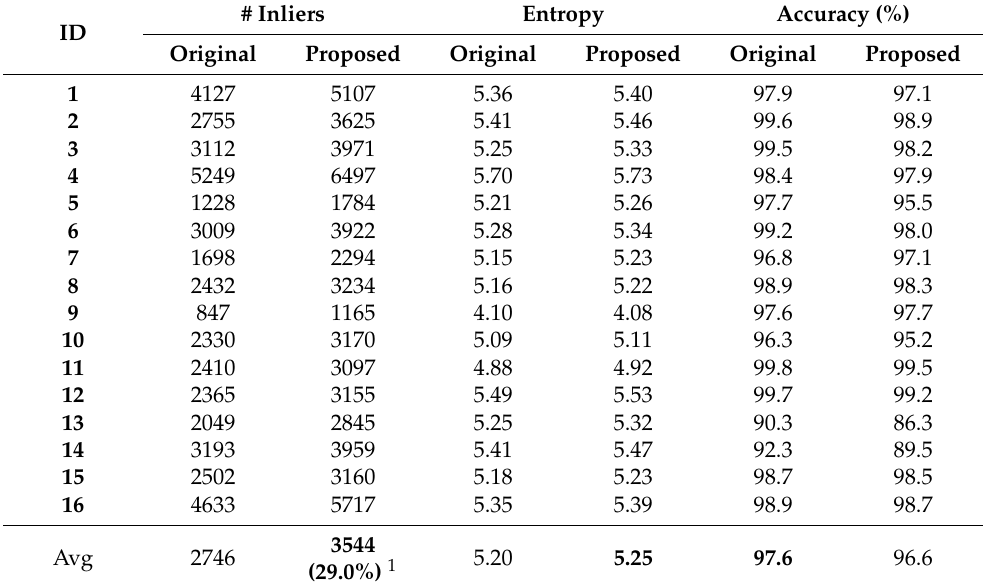
Table 1. Feature matching result between the ROI tangent image (ROI-TI) and the high-resolution planar image (HPI). We compared the original BF-based GMS Matcher (Original) and the kNN-based GMS Matcher (Proposed). The proposed approach can increase number of inliers (# Inliers) up to 29.0% compared to the original. It also increases the the matched features distribution (Entropy), which is the main purpose of the proposed approach. There is a slight reduction in Accuracy but the value is still high. # Inliers ID